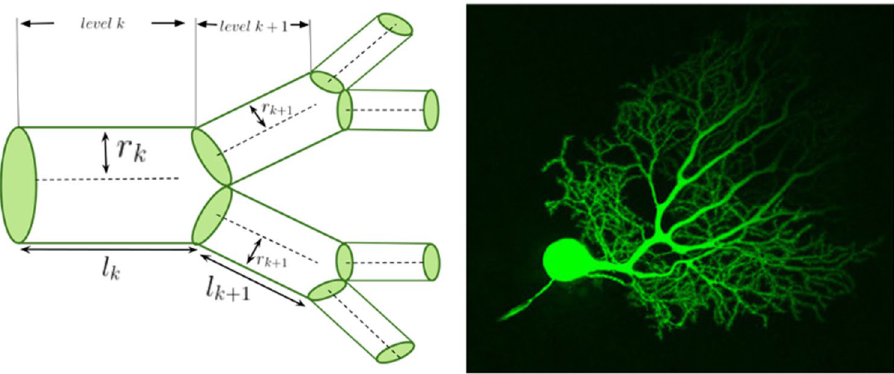
Figure 1. A hierarchical branching network. A visual depiction of the successive branching levels of a network and the quantities of interest alongside an image of a mouse cerebellar Purkinje neuron and its dendritic branching structure. This image was obtained using confocal microscopy and Lucifer yellow fluorescent dye. We have cropped this image available on CellImageLibrary.Org, distributed by Maryann Martone, Diana Price, and Andrea Thor 23